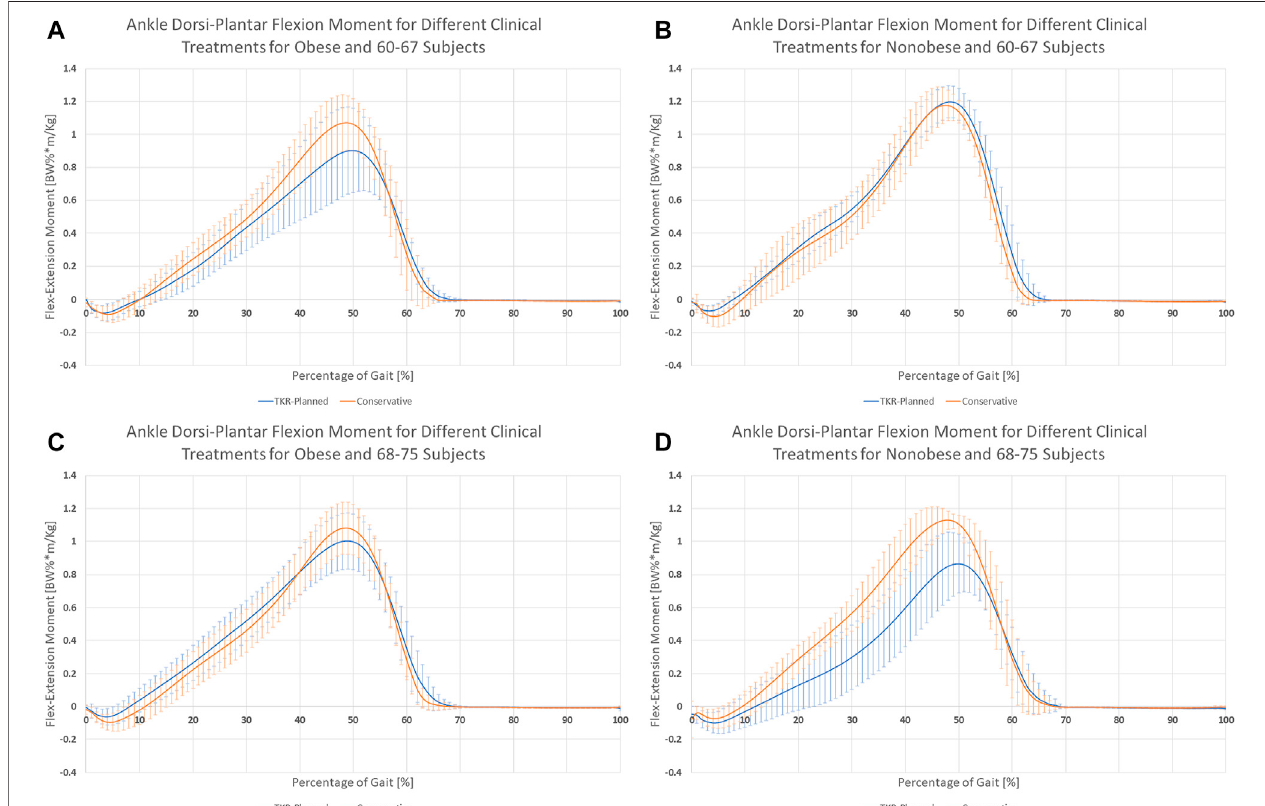
FIGURE7| Interaction betweenclinicaltreatment,BMI,andageoverankledorsi-plantar fl exion.Behaviordifferencesbetweenthetwoclinicaltreatmentarevisible in (A) obese subjects with age range 60 – 67 and (D) nonobese subjectswith age range 68 – 75. In (B) nonobese subjects age 60 – 67 and (C) obese subjects age 68 – 75, no signi fi cant differences are noticeable between the two clinical